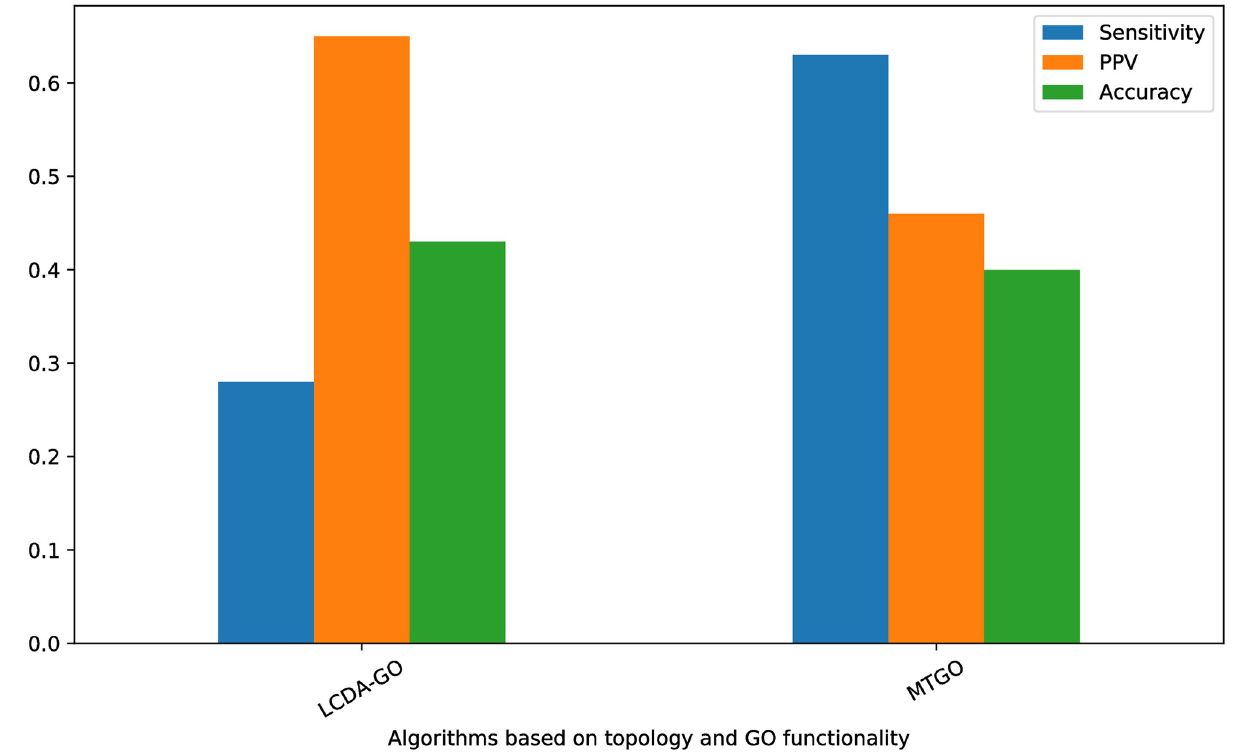
Fig 3. Comparing the results of LCDA - GO with MTGO on Krogan dataset.